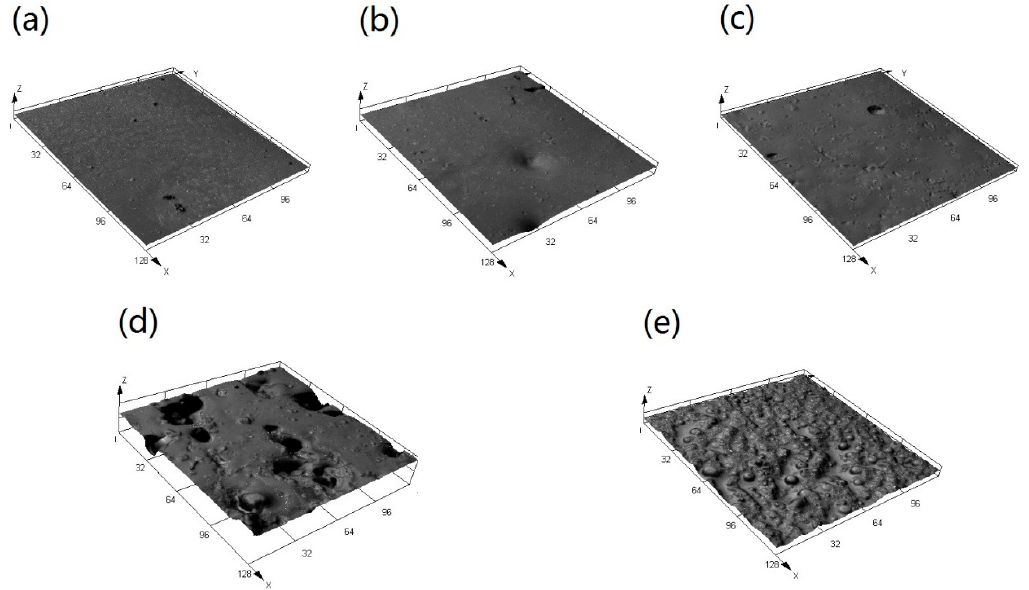
Figure 6. Morphology of the epoxy modified silicone coating: ( a ) ES-10; ( b ) ES-20; ( c ) ES-30; ( d ) ES-40; ( e ) ES-50.